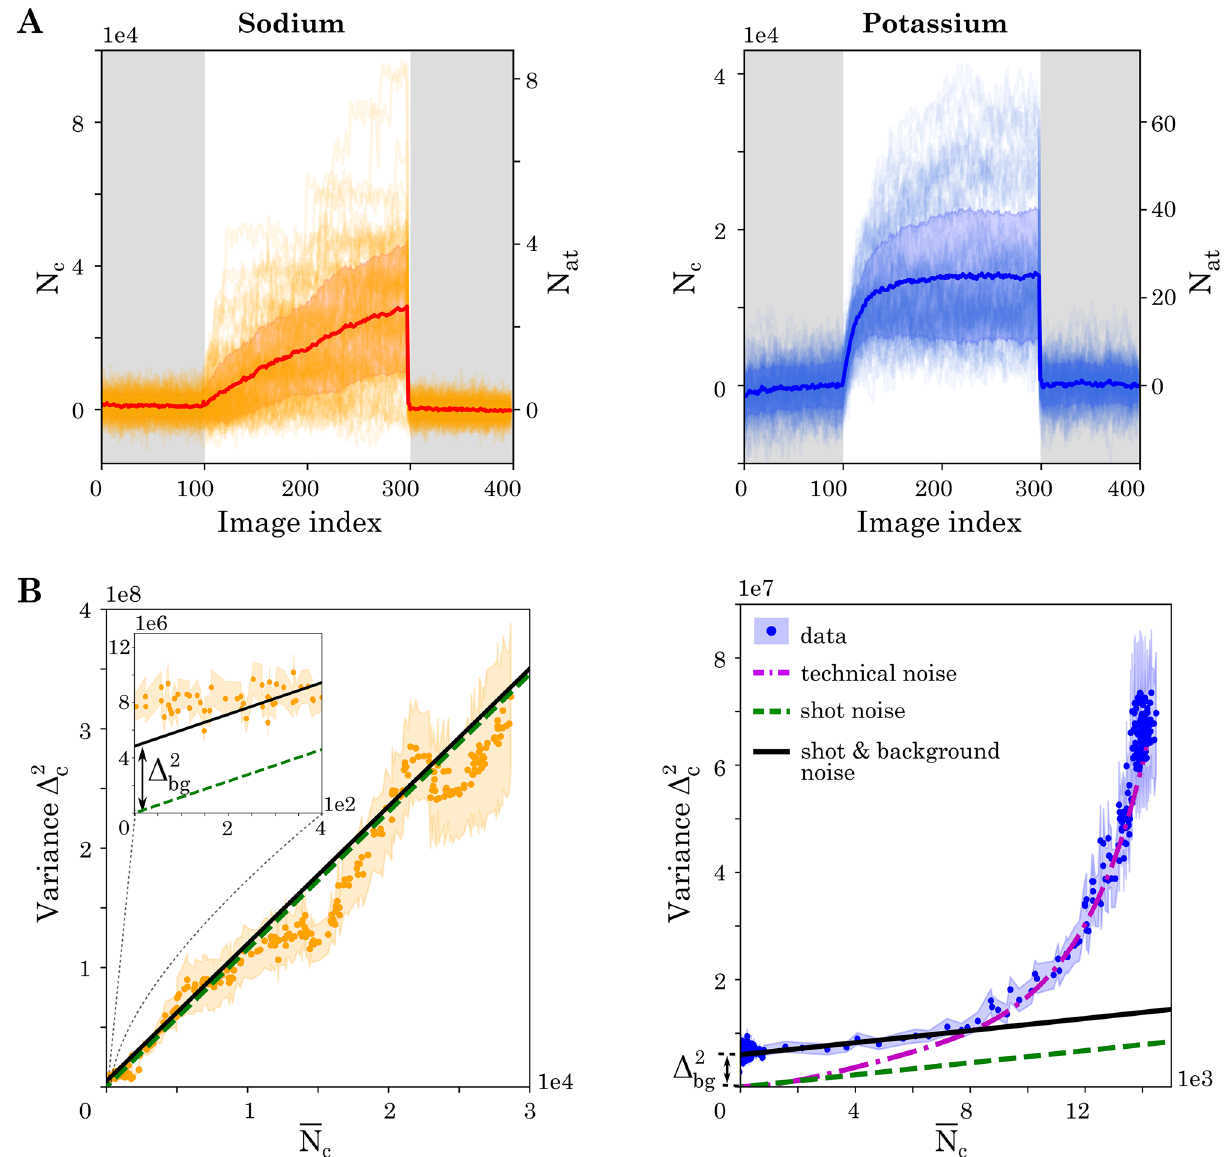
Figure 5. Characterization of atom number fluctuations for sodium (left) and potassium (right). A: Hundred time traces of sodium and potassium with mean and error band (shown as thick lines with shaded region around them). The figures show time traces both in units of camera counts ( N c ) and atom number ( N at ). B: Dependence of variance on mean camera counts. For sodium (left) the inset shows the background noise